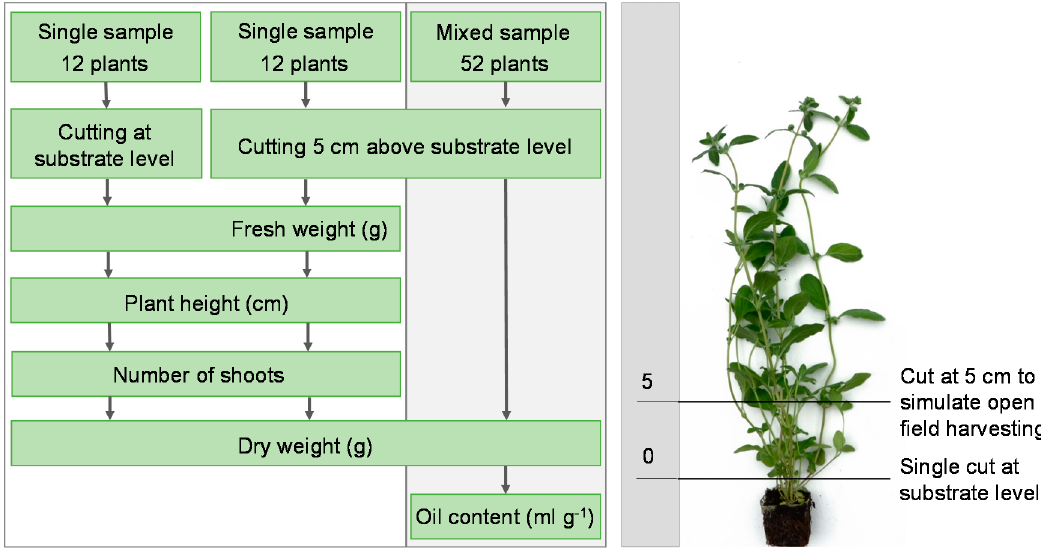
Figure 3. Exemplary representation of the data collection process during harvest as a flow chart.